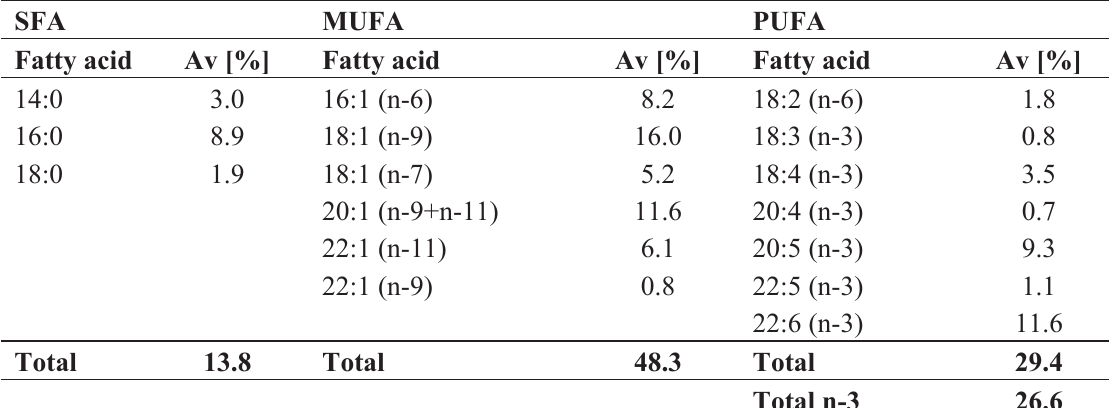
Table 1. Fatty acid composition of the fish oil determined by fatty acid methylation followed by separation through gas chromatography. Fatty acids are given in area%. SFA MUFA PUFA